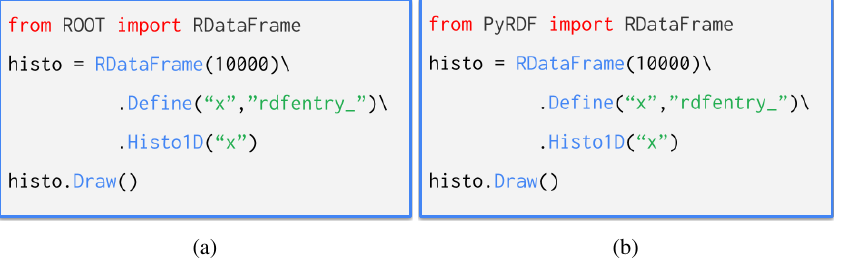
Figure 2: Code to generate a dataset with one column and plot an histogram out of it. (a): ROOT RDataFrame code. (b): PyRDF equivalent code: only the import directive changes.